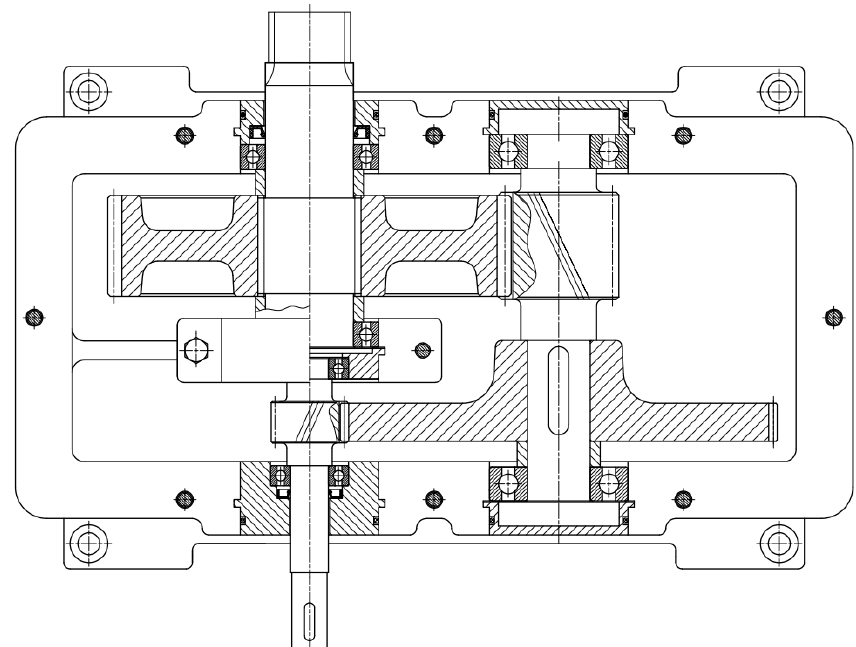
Figure 2. The typical example of the gearbox assembly drawing.